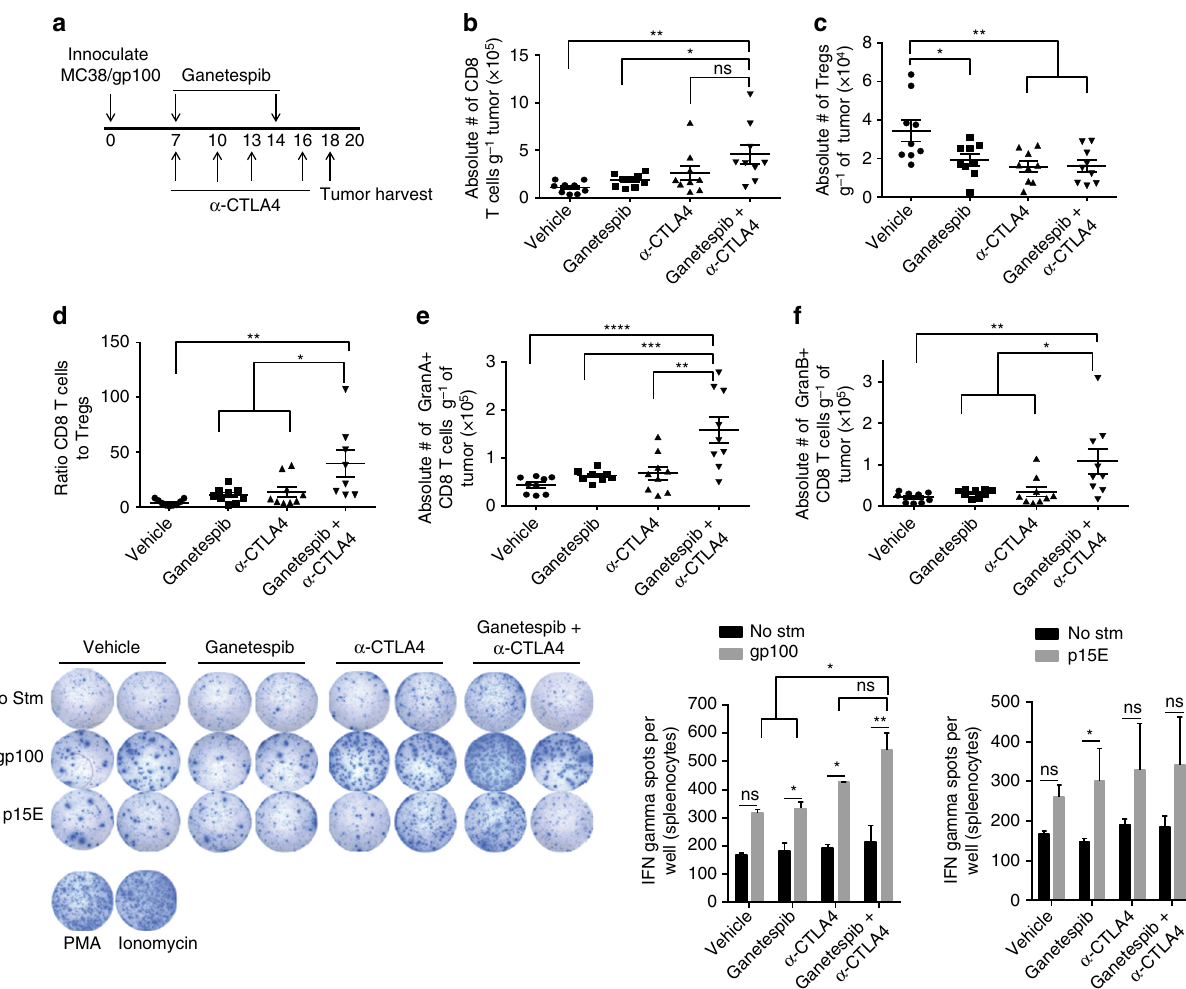
Fig. 4 Combining HSP90 inhibition and anti-CTLA4 enhances CD8 T-cell function. a Treatment schedule: ganetespib was administered at 100 mg/kg per mouse once a week and anti-CTLA4 at 100 μ g per mouse every 3 days. Two doses of ganetespib and 4 doses of anti-CTLA4 were administered. At day 18, mice were sacri fi ced, spleens harvested and processed, tumors were harvested and processed for RNA and immune cell in fi ltration pro fi led via fl ow cytometry. b Absolute number of CD8 T cells in fi ltrating the tumor normalized to tumor weight. c Absolute number of T regulatory cells in fi ltrating tumor normalized to tumor weight. d Ratio of CD8 T cells to Tregs in fi ltrating the tumor. e Absolute number of granzyme A positive CD8 T cells normalized to tumor weight. f Absolute number of granzyme B positive CD8 T cells normalized to tumor weight. n = 9 mice. g ELISPOTS showing gp100 and P15E-speci fi c cells from splenocytes of treated mice. The data represented as mean ± s.e.m. * P < 0.05; ** P < 0.01; *** P < 0.001; **** P < 0.0001 by one way ANOVA for B-F or paired two tailed Student ’ s t -test for G. Data are a representation of at least two independent